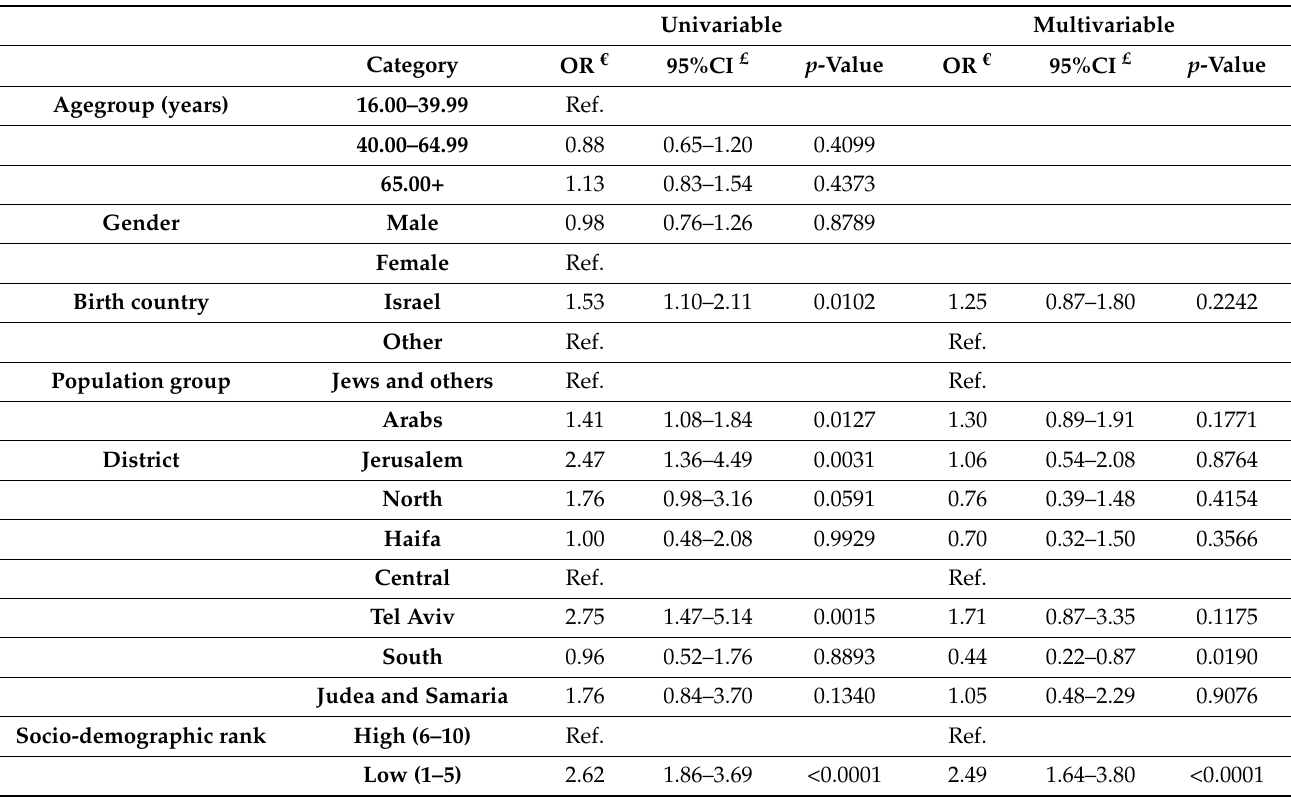
Table 3. Univariable and multivariable analyses for the association between SARS-CoV-2 seropositiv- ity and demographic characteristics in Israel, period 1 (January–December